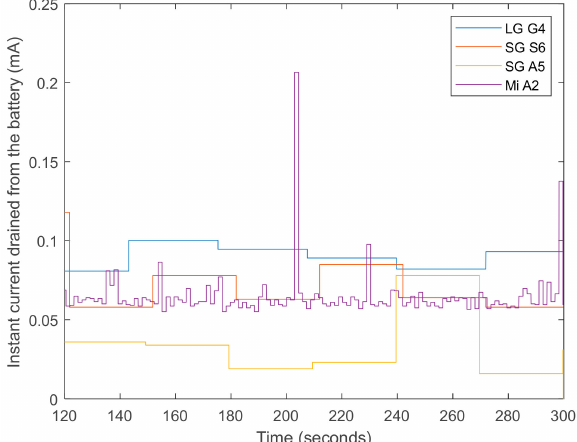
Figure 2. Snapshot of the evolution of the current drained for the four analyzed models for three particular minutes (from second 120 to 300) of the experiment with a frequency sample of 50 Hz and one connected sensing